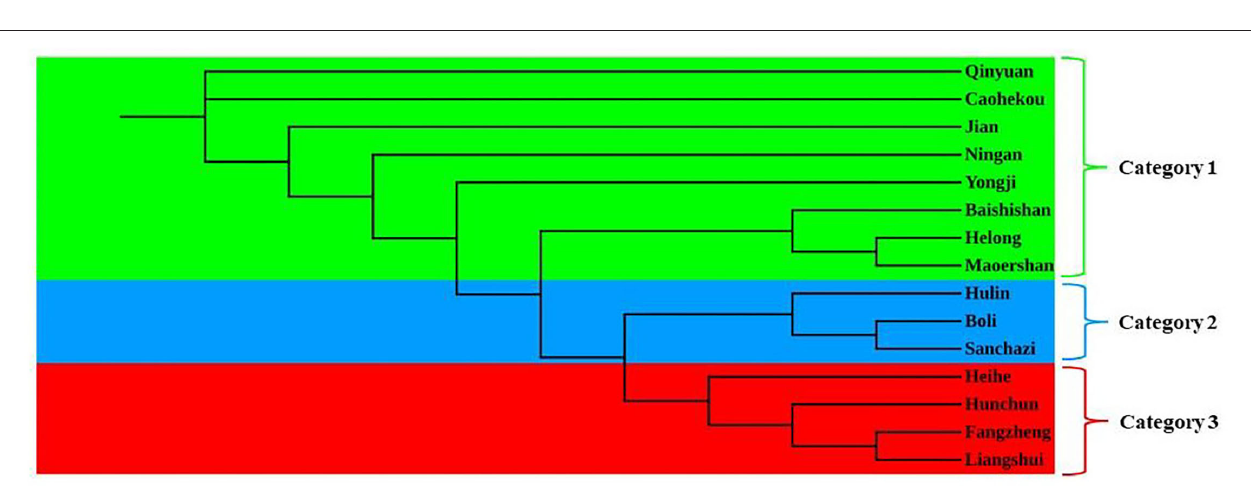
FIGURE 5 | Neighbor-joining tree of 15 J. mandshurica